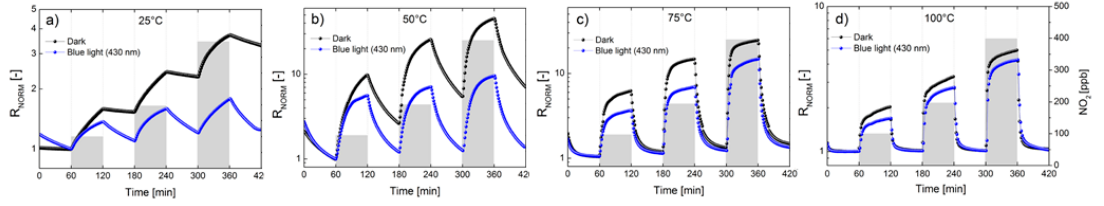
Figure 3. Comparison of the electrical responses in dark conditions and under purple-blue light ( λ = 430 nm) at different temperatures and NO 2 gas